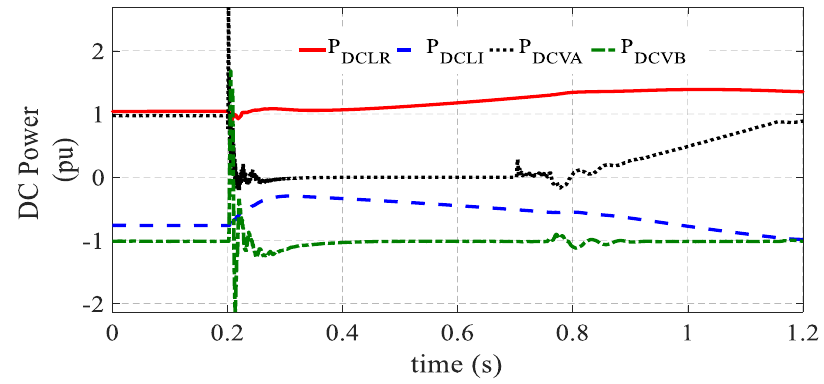
Figure 19. DC power measurements during a P-Pole-to-ground fault on VSC branch-A.